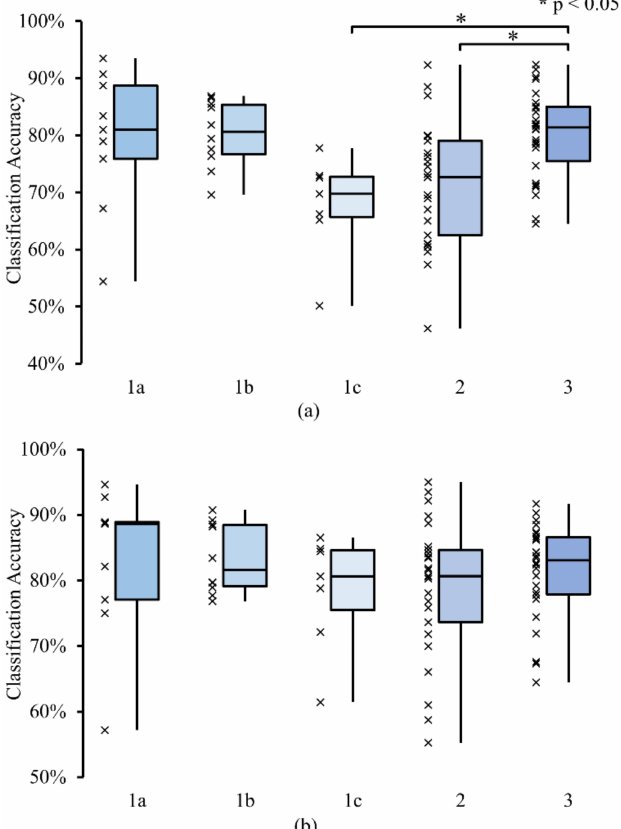
Figure 9. Box plot of the classification accuracy of each method using support vector machine (SVM) classifier ( a ) when using CSP feature set; ( b ) when using CSP+ feature set. The classification accuracies for individual participants are shown as x marks on the left of each box. An asterisk (*) denotes a significant difference in the classification accuracy between methods as indicated by the Kruskal–Wallis test with Bonferroni correction for multiple comparisons ( p < 0.05).